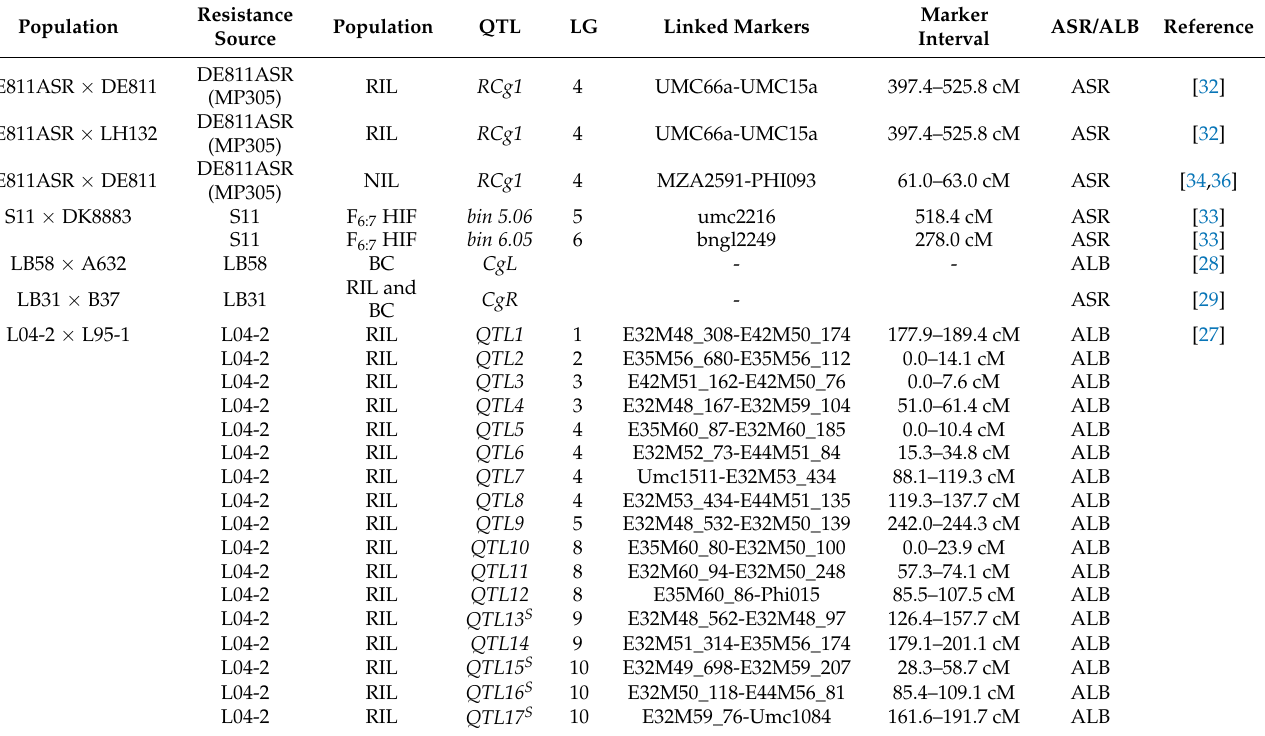
Table 1. QTL in maize conferring resistance to Anthracnose stalk rot and leaf blight caused by Colletotrichum graminicola